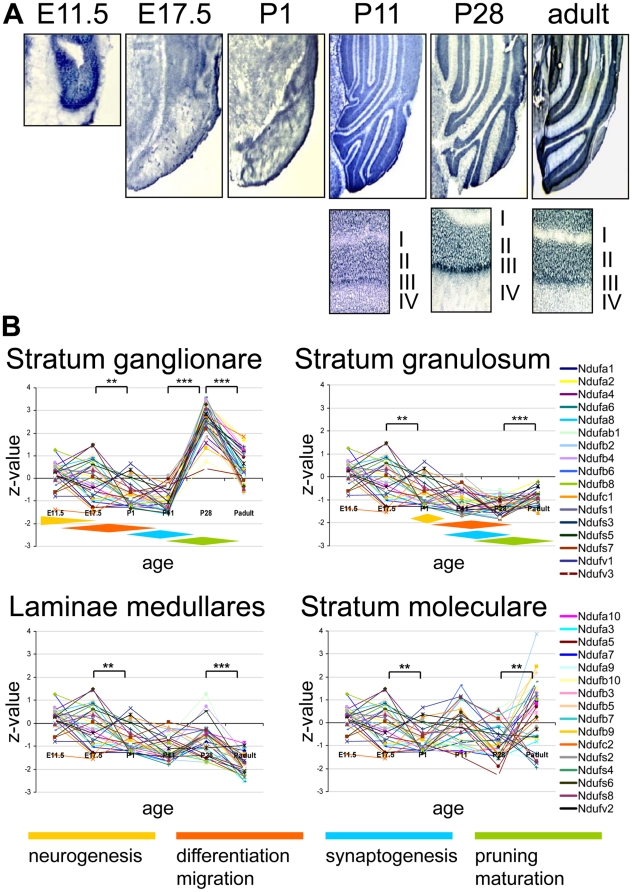
Complex I expression in the murine cerebellum.(A) ISH image for the complex I subunit Ndufb2 probe in the cerebellum during pre- and postnatal development. The images were recorded at x2.5 and the detailed insets at x10 magnification. The roman numbers depict the cerebellar layers: (I) Laminae medullares, (II) Stratum granulosum, (III) Stratum ganglionare, Purkinje cells and (IV) Stratum moleculare. Between E17.5 and P1 gene expression is only recorded for the cerebellar field (CE) and before that at E11.5 at the dorsal border of the rhomboid fossa (RF) (B) Z-transformed expression intensities for each probe plotted against the developmental age in the four cerebellar strata or the cerebellar field. The diamond shaped color fields illustrate the region specific stages of neuronal development. Significance levels of differences in expression are depicted by stars: *** p<0.0001; ** p<0.001.